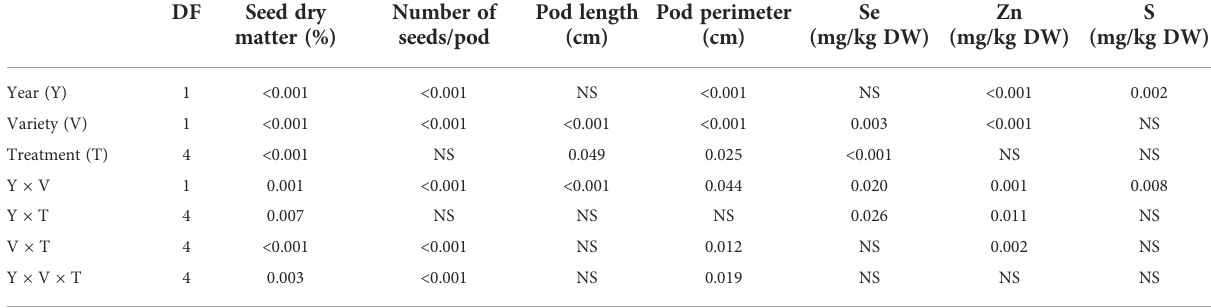
TABLE 1 Combined analysis of variance for the effects of year, variety, and treatment on seed dry matter, number of seeds per pod, pod length, pod perimeter, and seed Se, Zn, and S concentrations. DF Seed dry Number of matter (%)